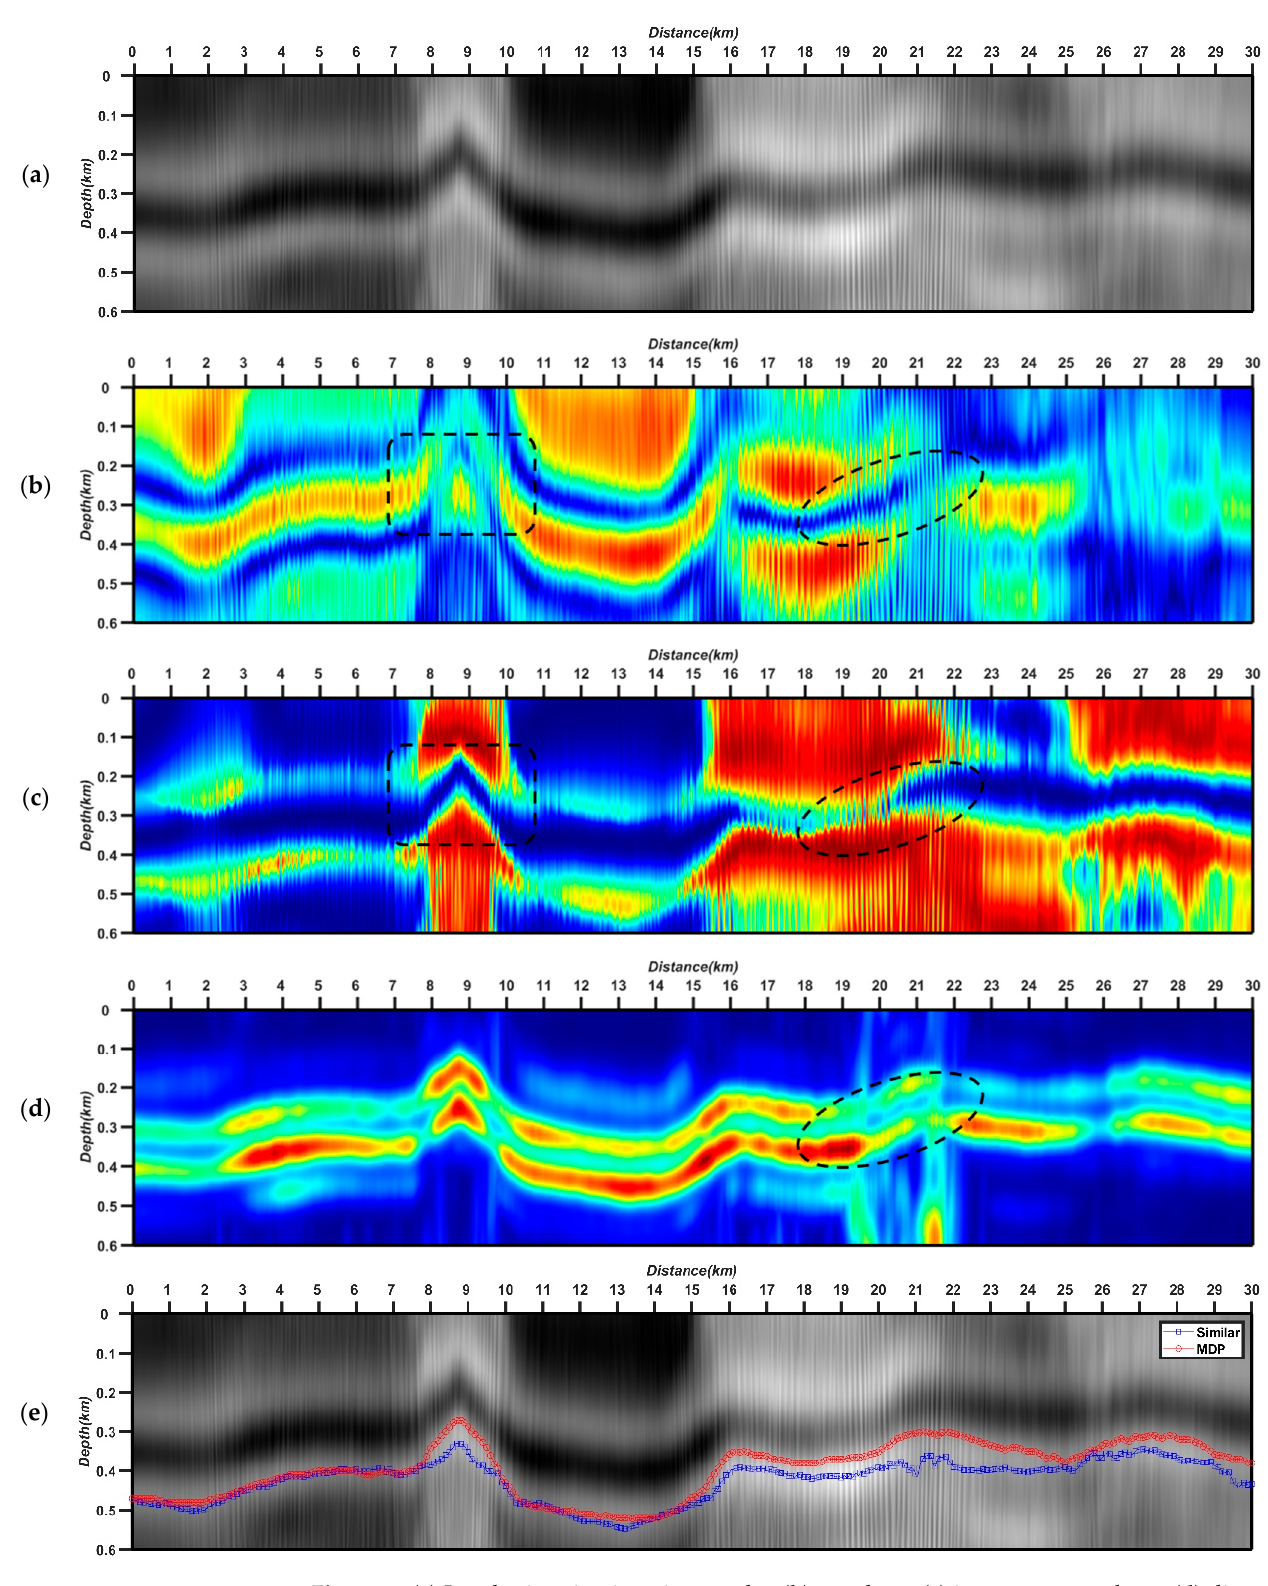
Figure 5. ( a ) Local migration imaging results, ( b ) envelope, ( c ) instantaneous phase, ( d ) dip, and ( e ) tracked horizon (the blue curve is the result via conventional waveform similar method, and the red curve is the result via the proposed method) overlaid with seismic image.